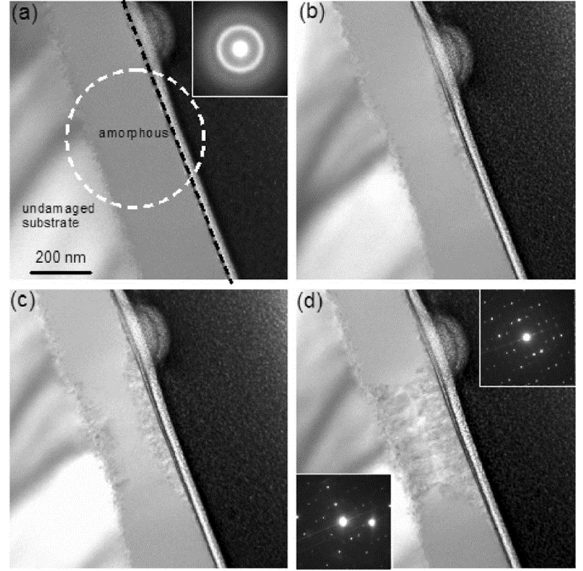
Figure 12. TEM images showing electron irradiation-induced structural changes of Sr 2 Nd 8 (SiO 4 ) 6 O 2 at the surface and the amorphous/crystalline interface at fluences of ( a ) 0, i.e., before irradiation, ( b ) 1.53 × 10 21 electrons/cm 2 , ( c ) 3.60 × 10 21 electrons/cm 2 , and ( d ) 6.55 × 10 21 electrons/cm 2 . Reproduced with permission from ref.